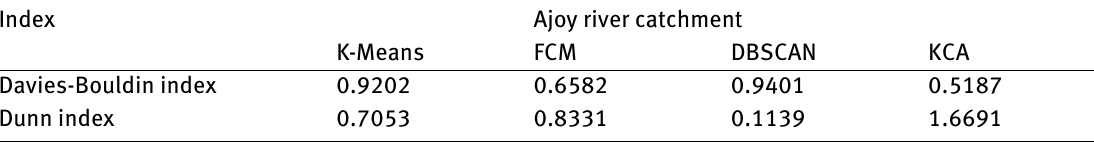
Table 6: Quantitative internal validity evaluation over Ajoy river catchment as obtained by K-means, FCM and KCA algorithms